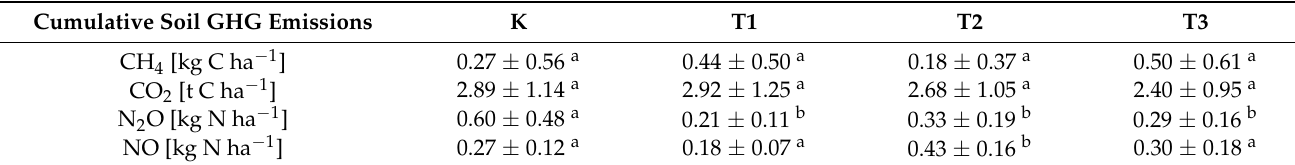
Table 3. Cumulative soil GHG emissions over a period of 155 days in 2014. Treatments are control (K) and three BC-compost treatments (T1, T2 and T3). For application rates of BC-compost and mineral fertilizer see Table